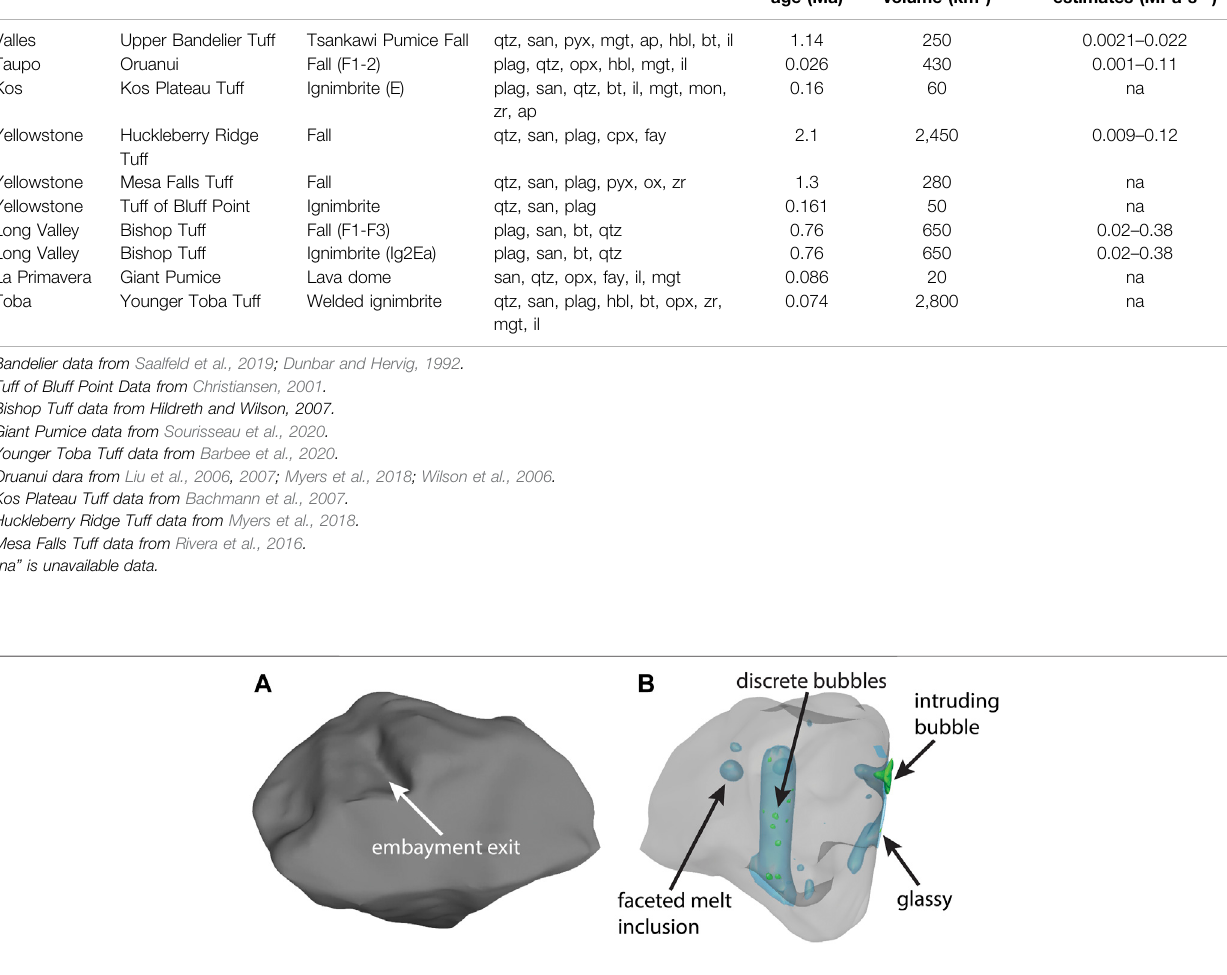
FIGURE1|(A) 3D tomography of a Bishop Tuff quartz crystal that hosts. (B) multiple glassy embayments with various bubble textures (gray (cid:1) quartz, blue (cid:1) glass, green (cid:1) bubble). Tomography performed at µCT beamline 8.3.2 at the Advanced Light Source, Lawrence Berkeley National Laboratory and segmented using Dragon fl y